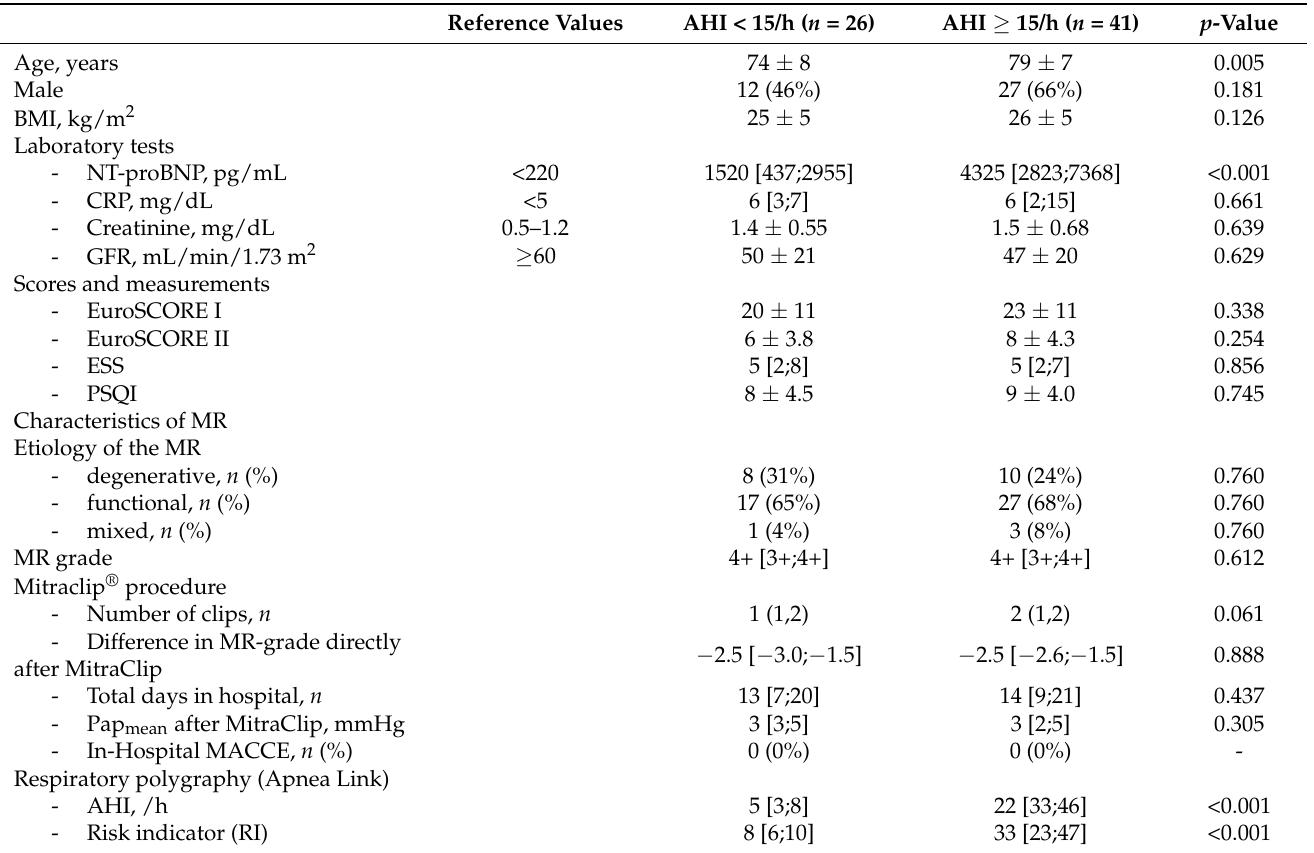
Table 4. Comparison of patients with versus without sleep disordered breathing